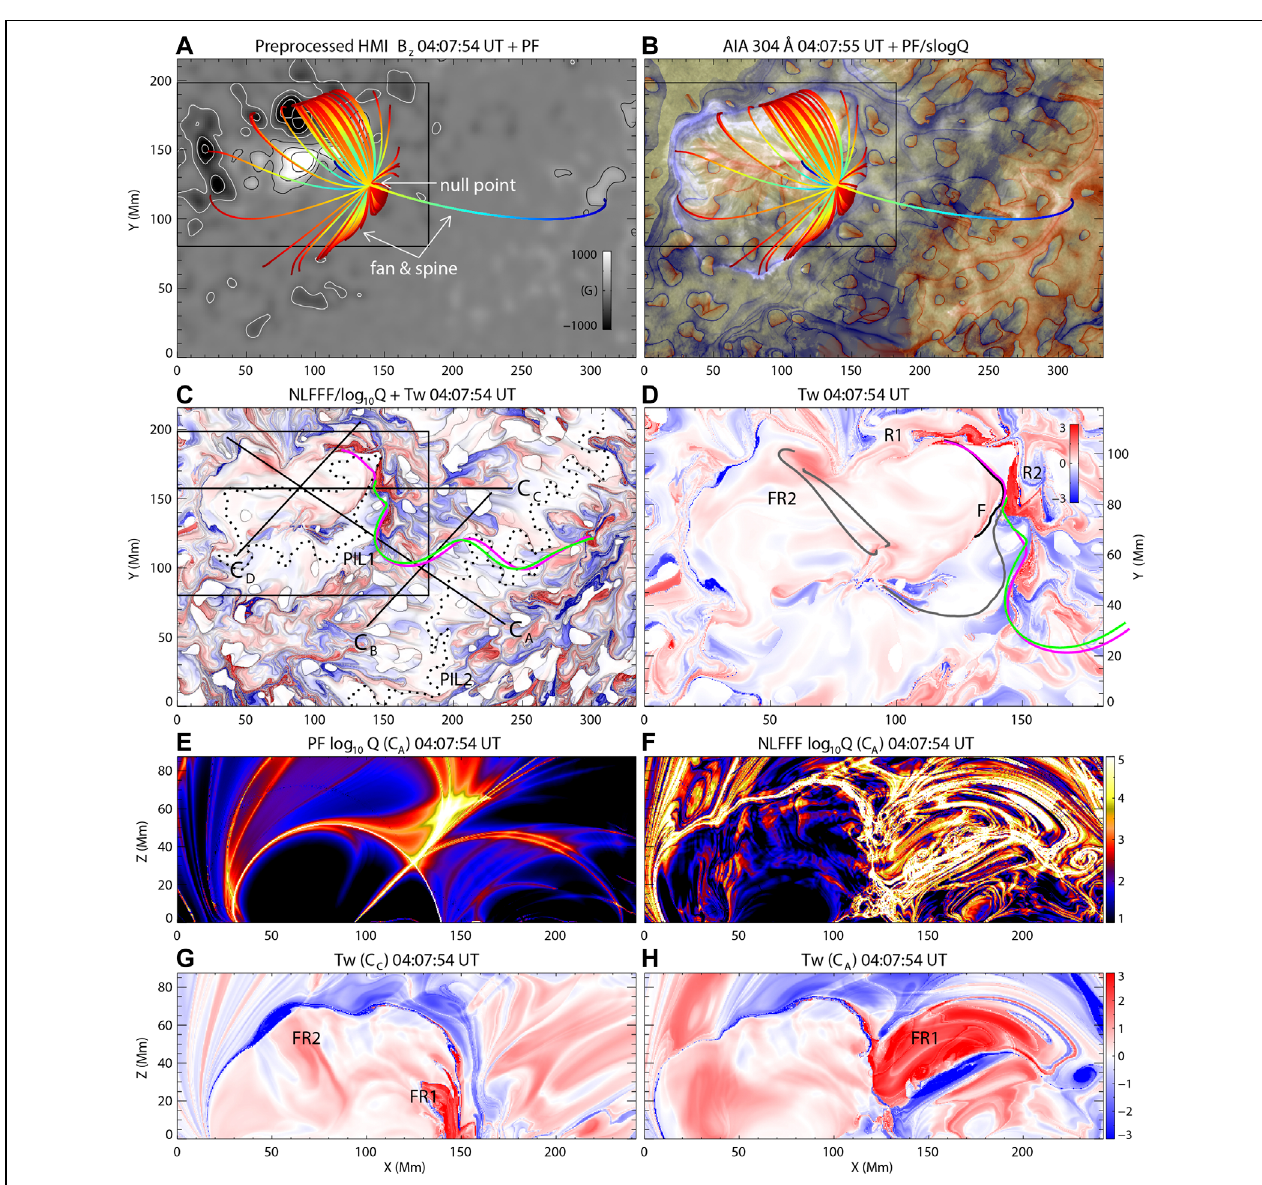
FIGURE 2 | Magnetic structure and topology over the active region before the flare. Selective potential field lines around the null point are plotted over the HMI Bz (A) and over a composite AIA 304 Å image blended with s log Q (B) . Maps of T w computed with the NLFFF in the range of ∓ 2 (blue/red) are shown as composite images blended with log Q above 1 (white) and below 5 (black) in the full box (C) and in a subregion (D) . Dotted lines show the PIL1 and PIL2. (D) Distribution of s log Q in the vertical plane CA passing through the null point predicted by the potential field (E) and the NLFFF (F) . Distribution of T w in the vertical plane CC (G) and CA (H) . (Source: Liu et al.,